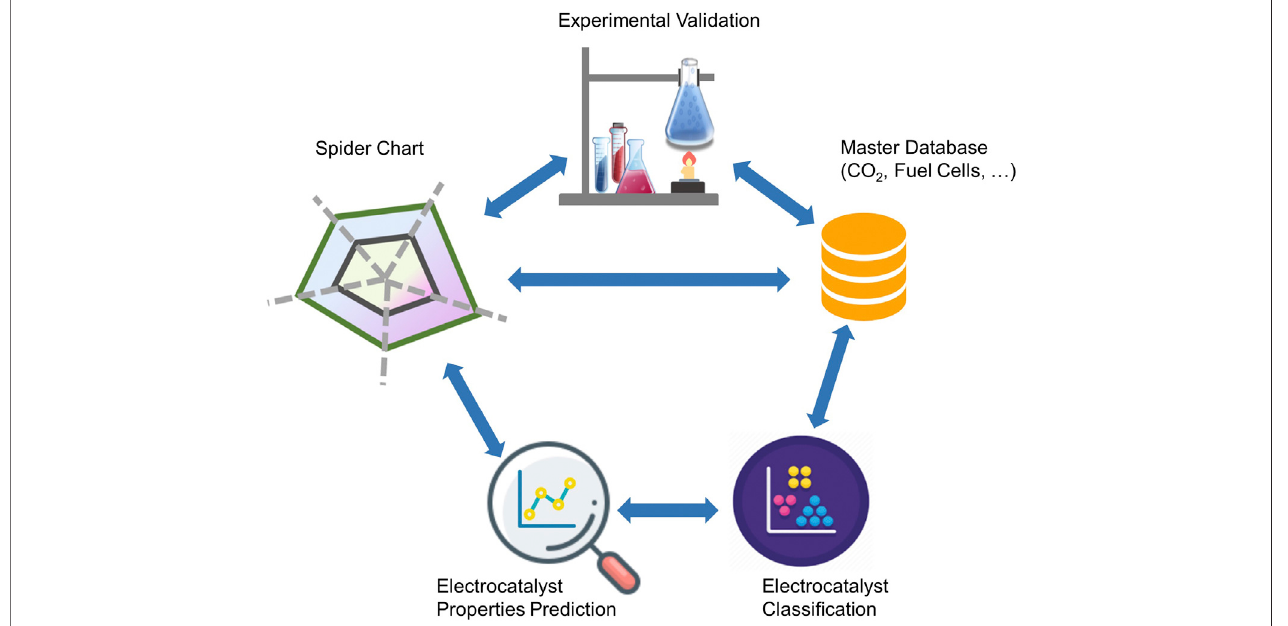
FIGURE 1 | The work fl ow of the cognitive material identi fi cation system.